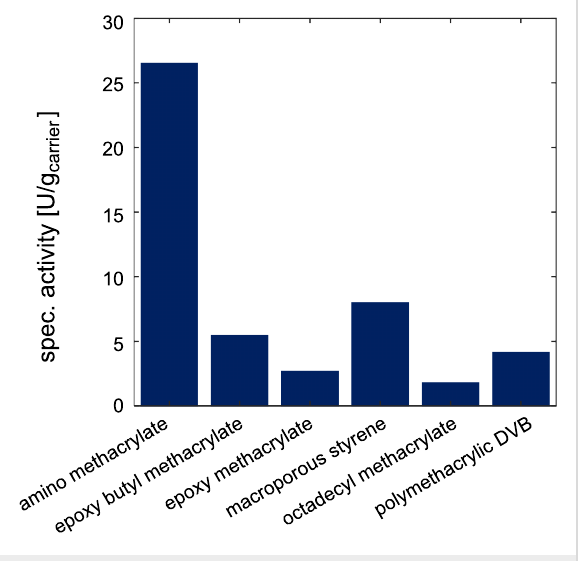
Figure 4: Evaluation of immobilized aldolase on different carriers with respect to specific activity. Reaction conditions: 40 °C, pH 8, 100 mM Tris, U shaking = 1400 rpm, V = 1 mL, 100 mM N -acetyl- ᴅ - mannosamine, 250 mM pyruvate, immo aldolase 5% (w/v).